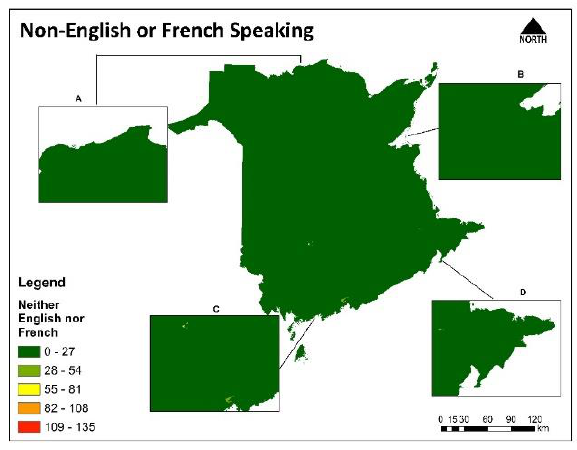
Geosciences 2020 , 10 , x FOR PEER REVIEW Figure A10. Population Speaking Neither English Nor French. Figure A10. Population Speaking Neither English Nor French. Figure A10. Population Speaking Neither English Nor French.